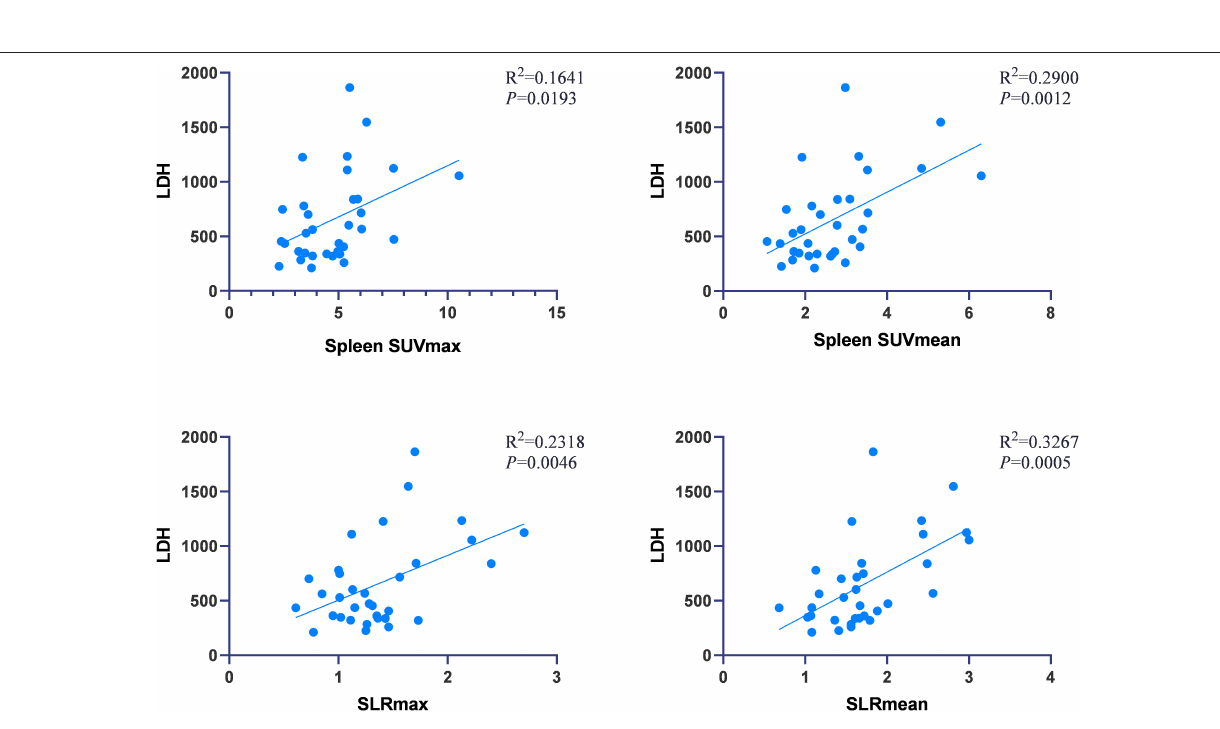
Frontiers in Medicine |